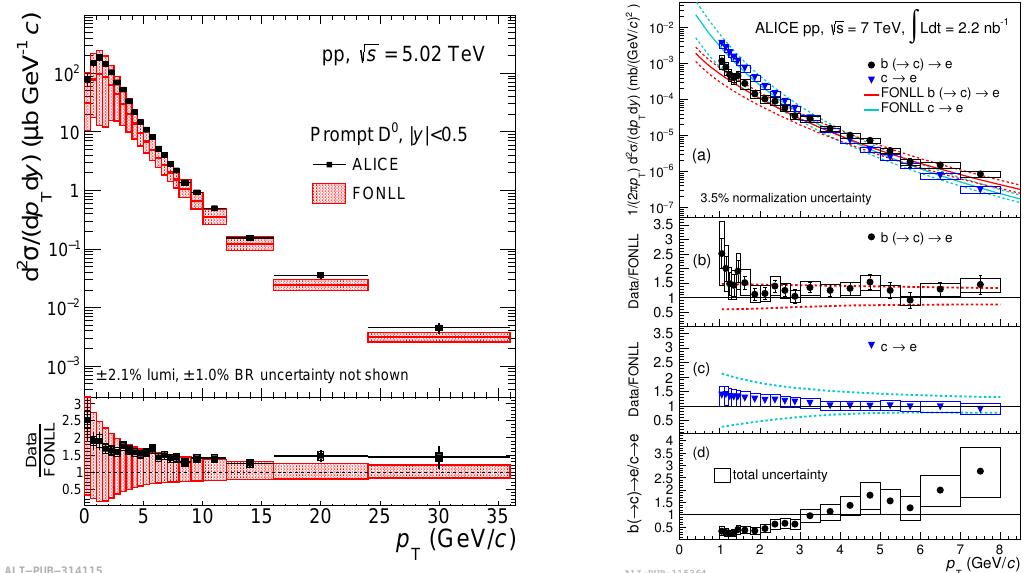
√ s NN = 5.02 TeV, compared to